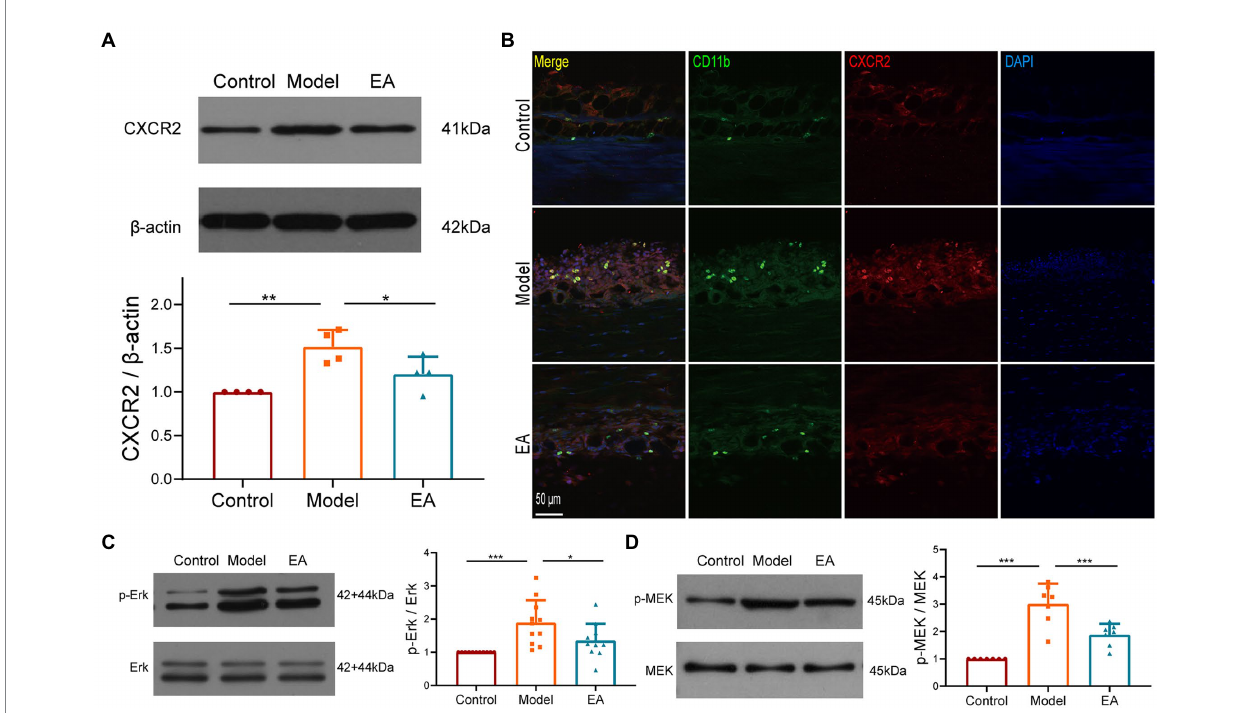
FIGURE 7 The anti-inflammatory effect of EA on synovitis is mediated by suppressing the CXCL1-CXCR2 axis. (A) The expression of CXCR2 protein in the synovium was measured using Western Blotting ( n = 3, * p < 0.05, ** p < 0.01). (B) The co-expression of CXCR2 and the CD11b + macrophage in the synovium ( n = 3). (C) The expression of phosphorylation ERK in the synovium. (D) The expression of phosphorylation MEK in the synovium. n = 4–6 in each group ( n = 3, * p < 0.05, ** p < 0.01, *** p <